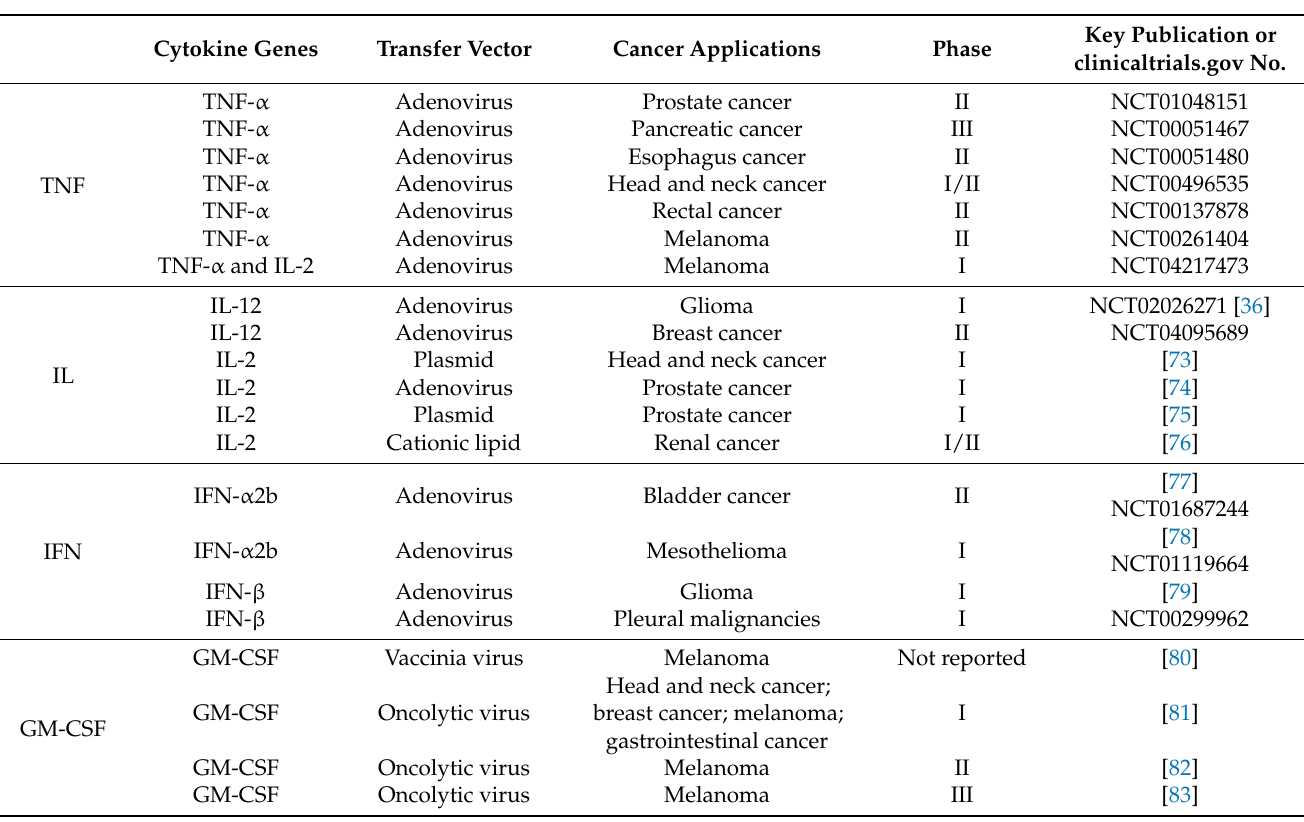
Figure 2. Clinical progress on inflammatory cytokine gene therapies. Table 1. Important previous or ongoing clinical trials with inflammatory cytokine gene therapies.